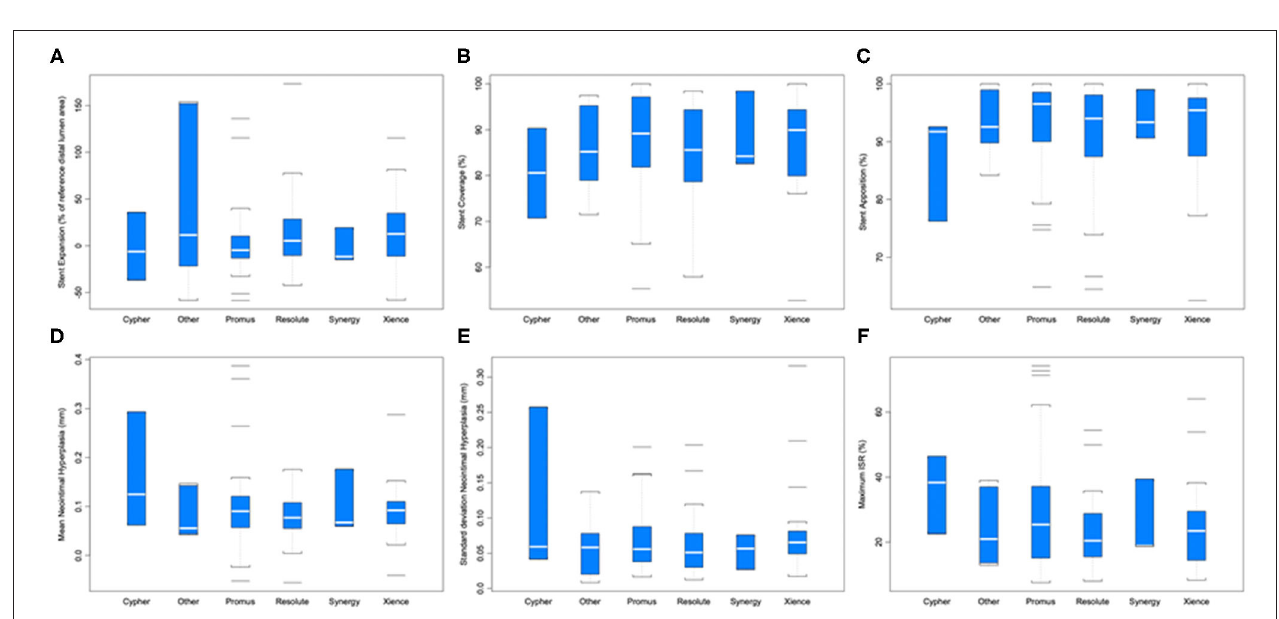
FIGURE 3 | Distribution of days between stent placement and OCT evaluation.